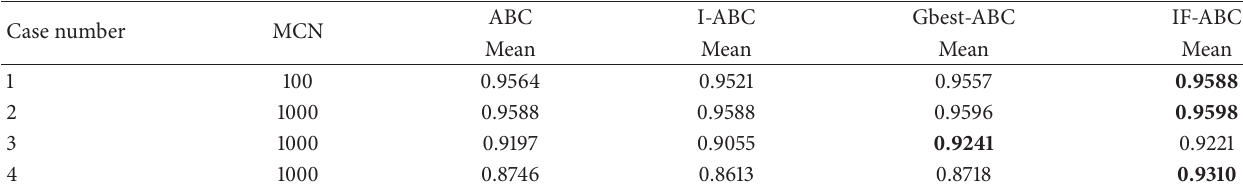
Figure 4: Ideal template matching case 2: traditional Chinese seal patterns. (a) Predefined template image (84 × 88); (b) source image (552 × 479); (c) ground matching truth (blue box) and most common false matching result (red box); (d) comparative evolution curves of four ABC algorithms; (e) surface illustration of searching space. Table 3: Comparative convergence performances of four ABC relevant